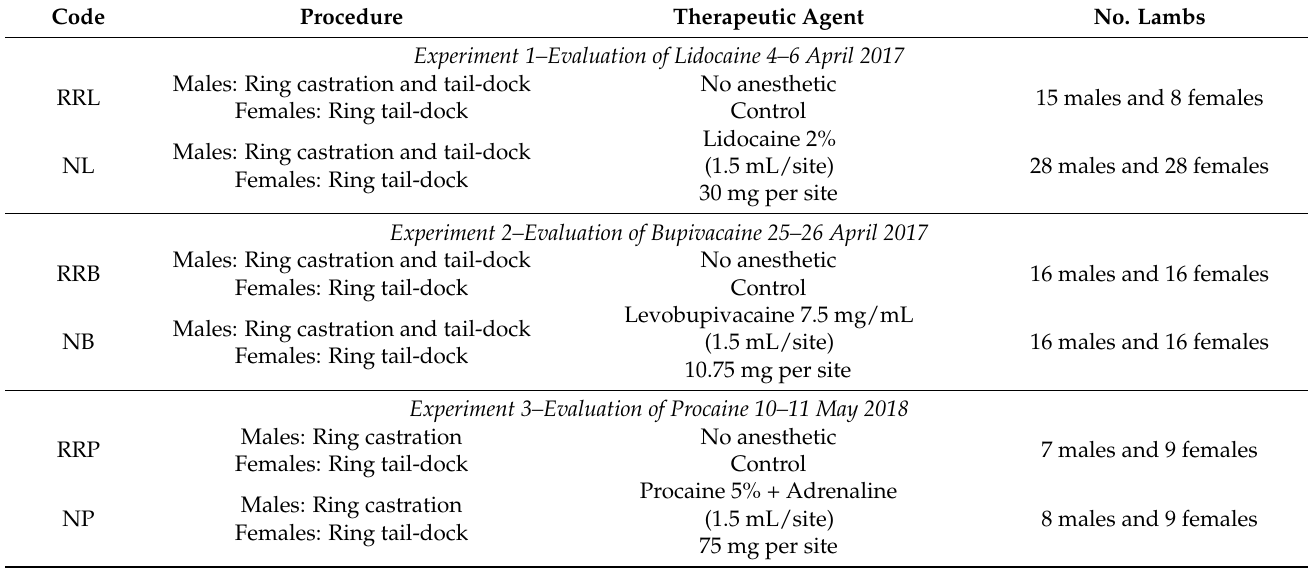
Table 1. Distribution of lambs by husbandry procedure and treatment in the three trials.